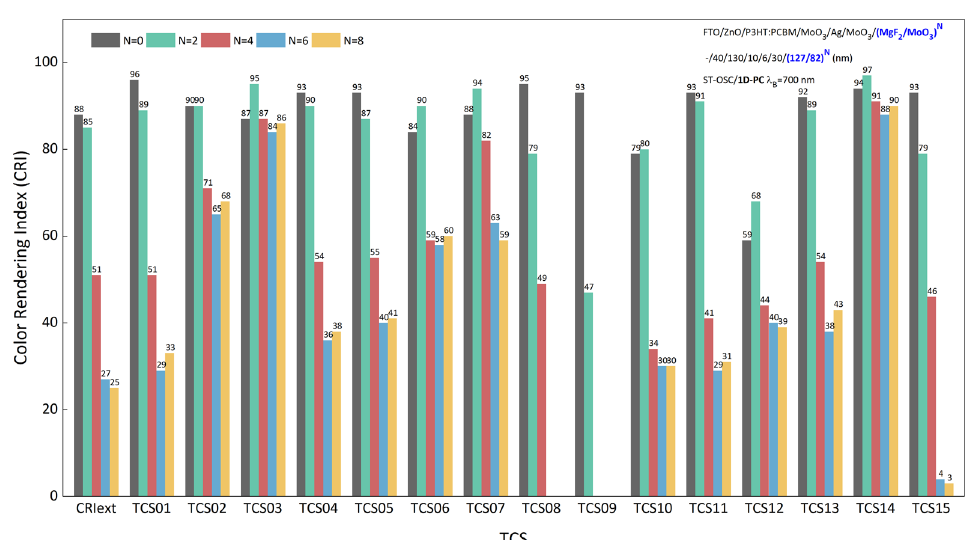
Figure 5. Color rendering characteristic of a semi-transparent organic solar cell. CRI and TCSs for λ B = 700 nm in N = 2, 4, 6, 8 periods in ST-OSC/(MgF 2 /MoO 3 ) N